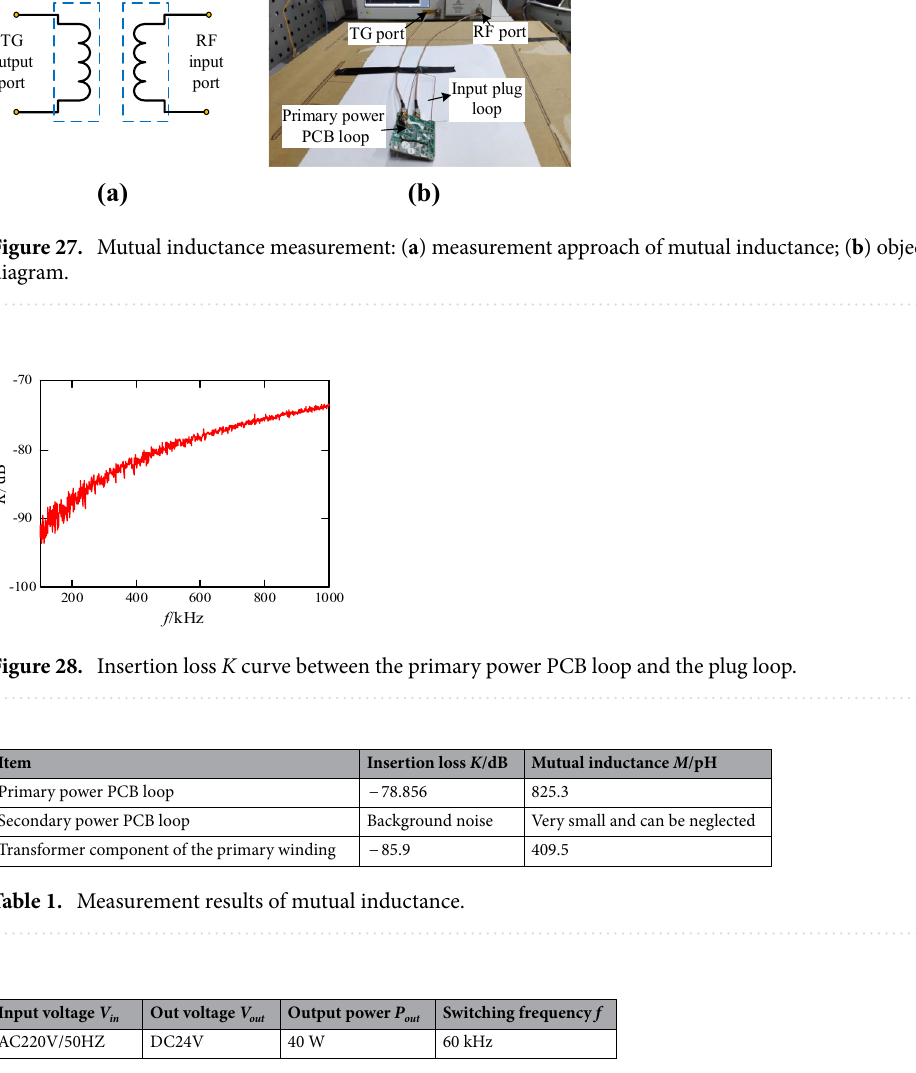
Table 2. Main electrical parameters of the